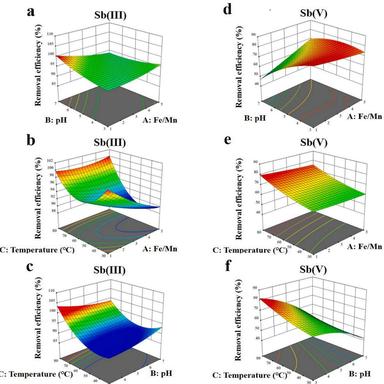
Three dimensional response surface plots showing the variation in removal efficiency with Fe: Mn and pH for Sb(III) (a) and Sb(V) (d); Three dimensional response surface plot showing the variation in removal efficiency with temperature and Fe: Mn for Sb(III) (b) and Sb(V) (e) and three dimensional response surface plot showing the variation in removal efficiency temperature and pH for Sb(III) (c) and Sb(V) (f).